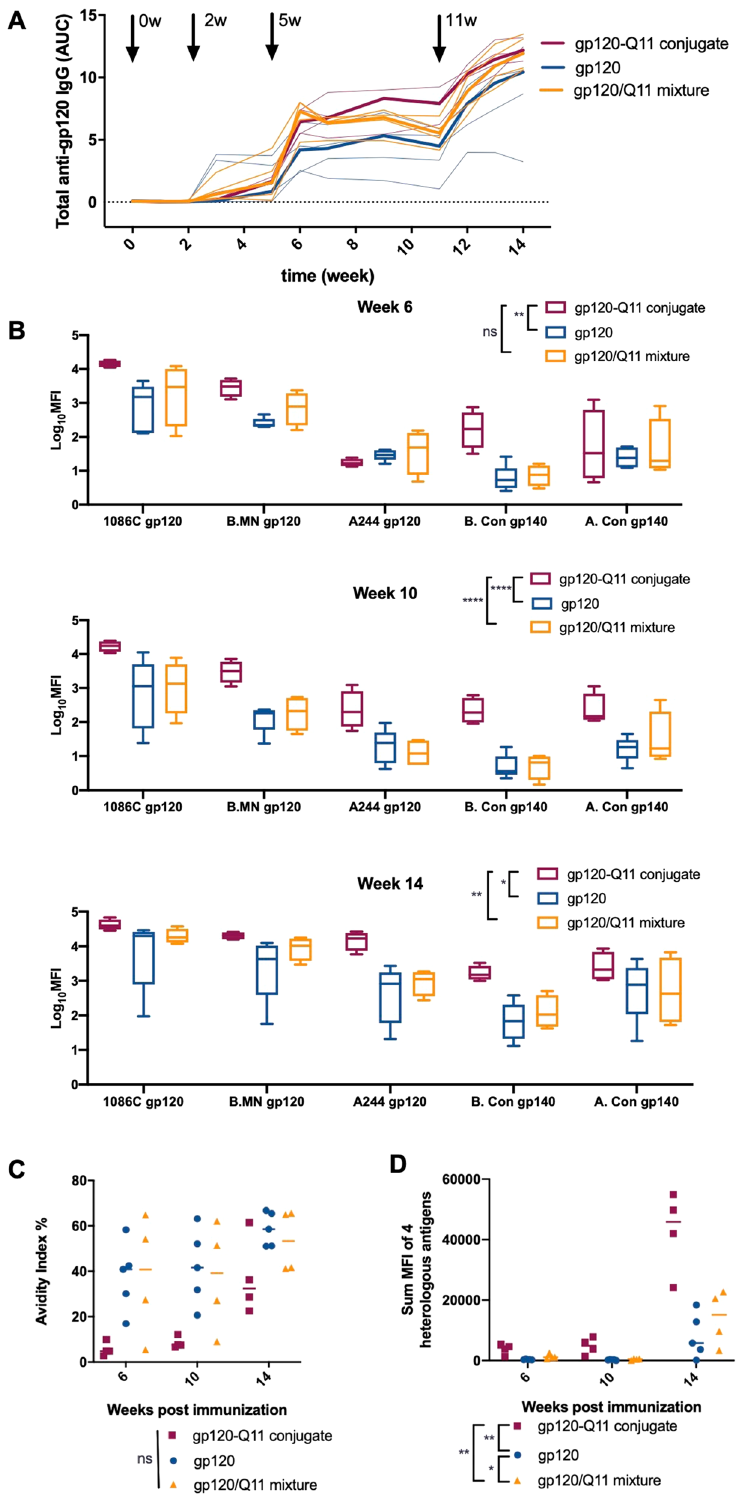
Figure 2. Nanofiber conjugation increases antibody binding breadth. ( A ) Magnitude of serum antibody responses to gp120 from mice immunized with gp120 or gp120 nanofibers at times indicated by arrows as measured by ELISA. Bold line shows mean titer and thin lines show individual responses. Mice received 4 total immunizations of 50 μg gp120 each. Responses were compared using a linear mixed effects model and no significant difference was observed. ( B ) Binding of serum antibodies to a panel of heterologous antigens at 6, 10, and 14 weeks post immunization. Groups were compared using GEE (see methods for more detail). ( C ) Avidity index of serum antibodies to gp120 measured by antibody binding under denaturing conditions. ( D ) Time progression of heterologous antigen binding displayed by summing the responses shown in ( B ). Groups were compared using a repeated measures non-parametric test with differences between treatment groups denoted on graph legends. * p < 0.05, ** p < 0.01, **** p < 0.0001. (n = 4 animals/group for gp120-Q11 and gp120/Q11, n = 5 animals/group for